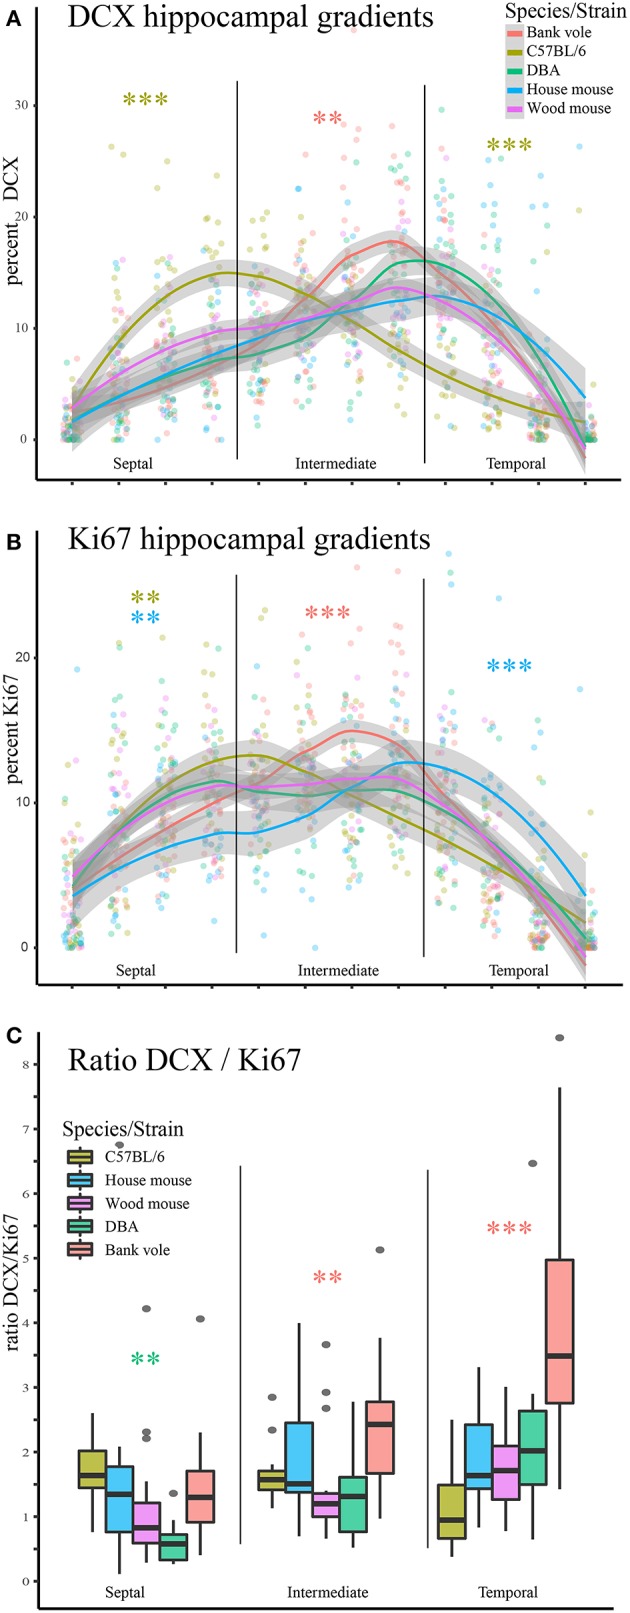
Opposite neurogenesis gradient in laboratory C57BL/6. Values of young neurons and proliferating cells were re-calculated as percentage for each animal to allow statistical comparisons. (A) C57BL/6 is distinct from other species and strains in the septal subdivision with significantly more young neurons than all other species (all p < 0.01) and significantly fewer young neurons in the temporal subdivision (all comparisons p < 0.05). In the intermediate hippocampus, bank voles have higher DCX values than C57BL/6, DBA and house mice. (B) Septo-temporal distribution of proliferating cells is overall more similar, however, in the septal subdivision the extremes are represented by C57BL/6 (high) and house mice (low), which are significantly different from DBA, bank voles and wood mice. In the intermediate hippocampus, bank voles score higher than all other species (p = 0.002 to < 0.0001). In the temporal subdivision house mice have more proliferating cells than all other species (p = 0.006 to < 0.0001). As a proxy for young neuron survival, the ratio of DCX+ cells to Ki67+ cells is presented in (C), separately for the three hippocampal subdivision. Survival rate is lowest in DBA in the septal subdivision. Bank voles score higher in survival rate than DBA and wood mice in the intermediate (p < 0.01). In the temporal subdivision, neuronal survival in bank voles excels all other species values (p < 0.001). *p < 0.05, **p < 0.01, and ***p < 0.001; color-coding corresponds to the species/strain showing the difference, for exact values see results.